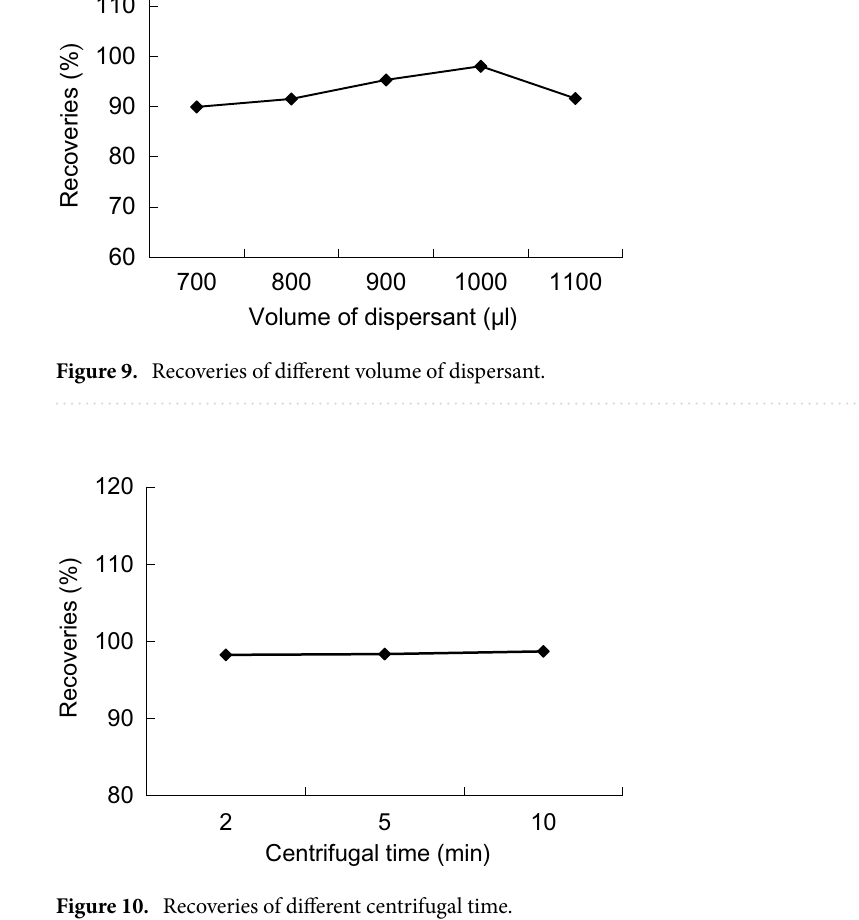
Figure 10. Recoveries of different centrifugal time.